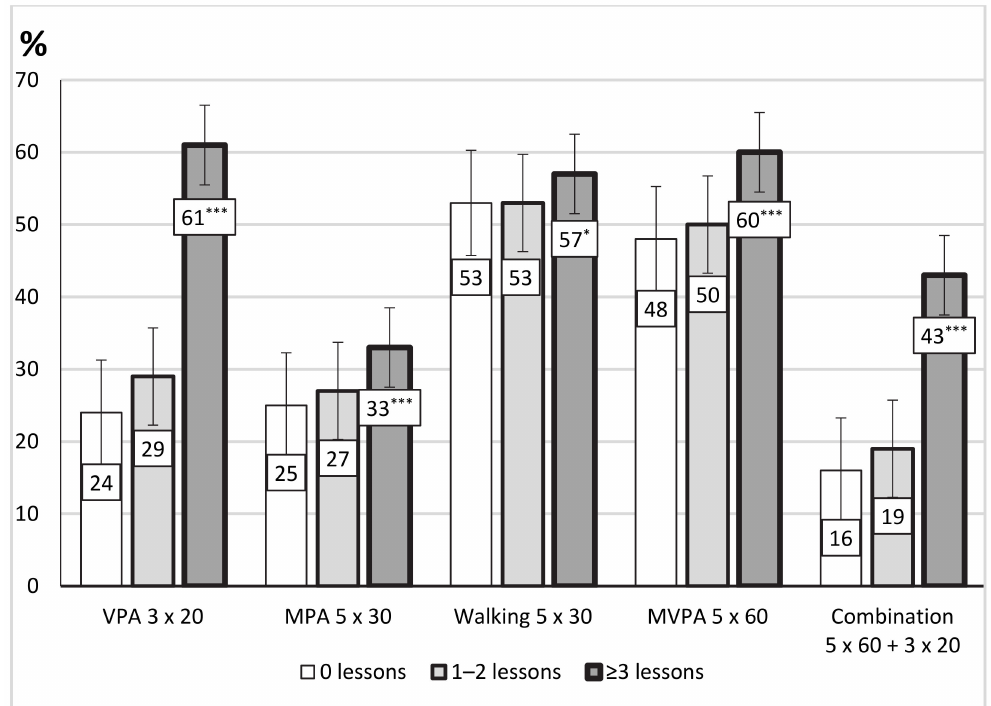
Figure 1. Achievement of the recommendations for weekly physical activity(PA) (3 × 20 min of vigorous PA (VPA), 5 × 30 min of moderate PA (MPA), 5 × 30 min of walking, 5 × 60 min of moderate to vigorous PA (MVPA), and 5 × 60 min of MVPA combined with 3 × 20 min of VPA) by adolescents’ participation in organized physical activity. Significant difference between groups (0 lessons and ≥ 3 lessons of OPA): * p < 0.05; *** p <